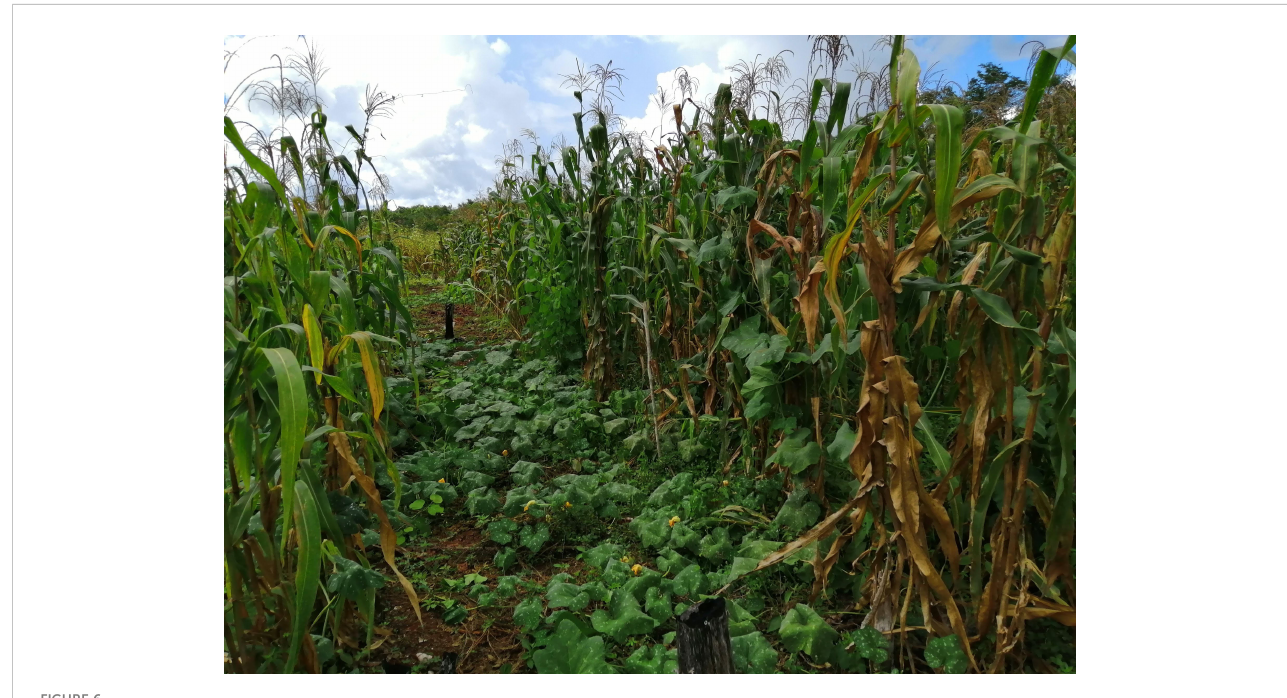
FIGURE 6 Milpa in Yaxcaba on the Yucatan Pensinsula,